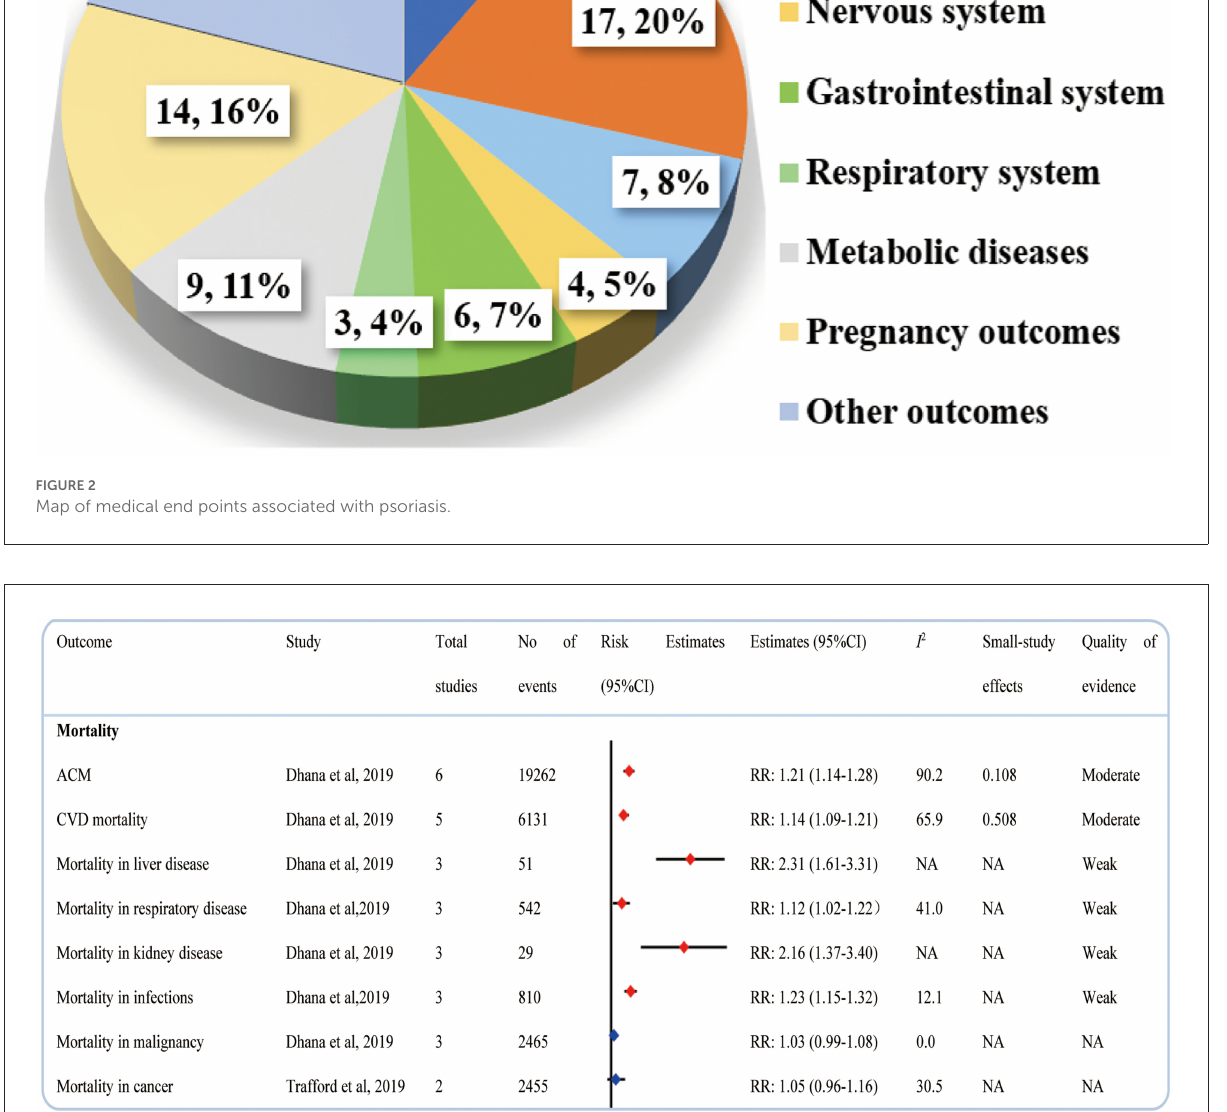
however, psoriasis was not associated with an increased risk of congenital malformations, neonatal mortality, stillbirth, spontaneous abortion, antepartum or